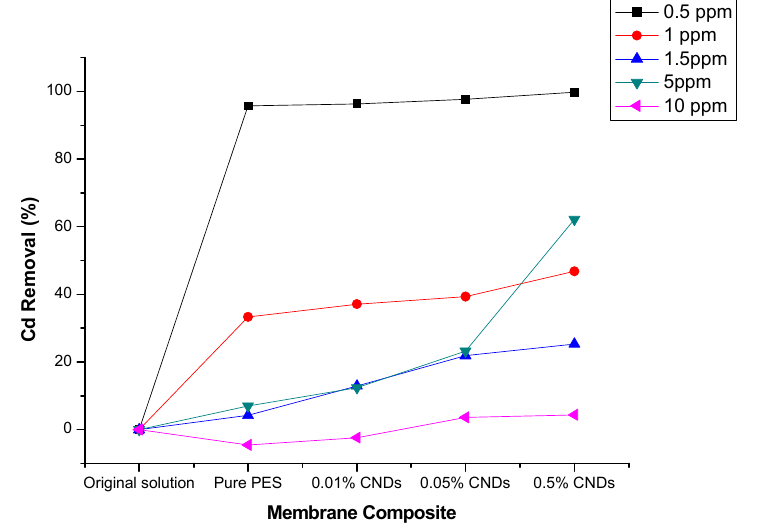
Figure 12. Effect of standard concentrations for the removal of cadmium(II) from standard solutions. Table 4. Comparison of differently modified PES membranes for Cd 2+ removal from standard samples.